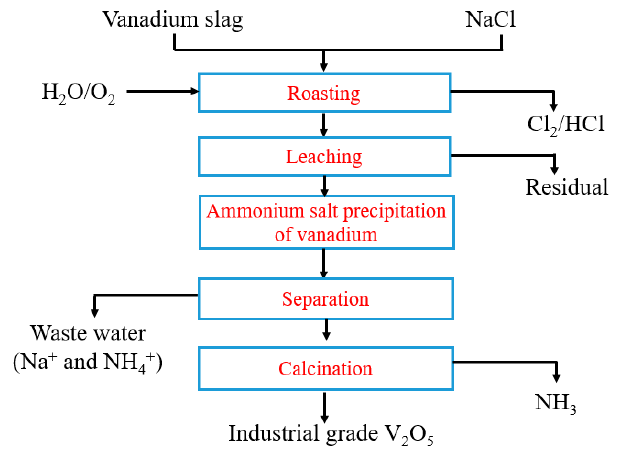
Figure 5. Flow chart of extracting vanadium from vanadium slag by NaCl roasting.